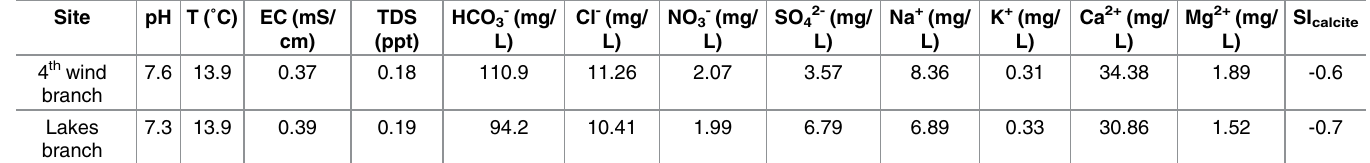
Table 1. Water chemical parameters from representative areasin the cave. SI calcite was calculatedusing the Merlak algorithm[37].